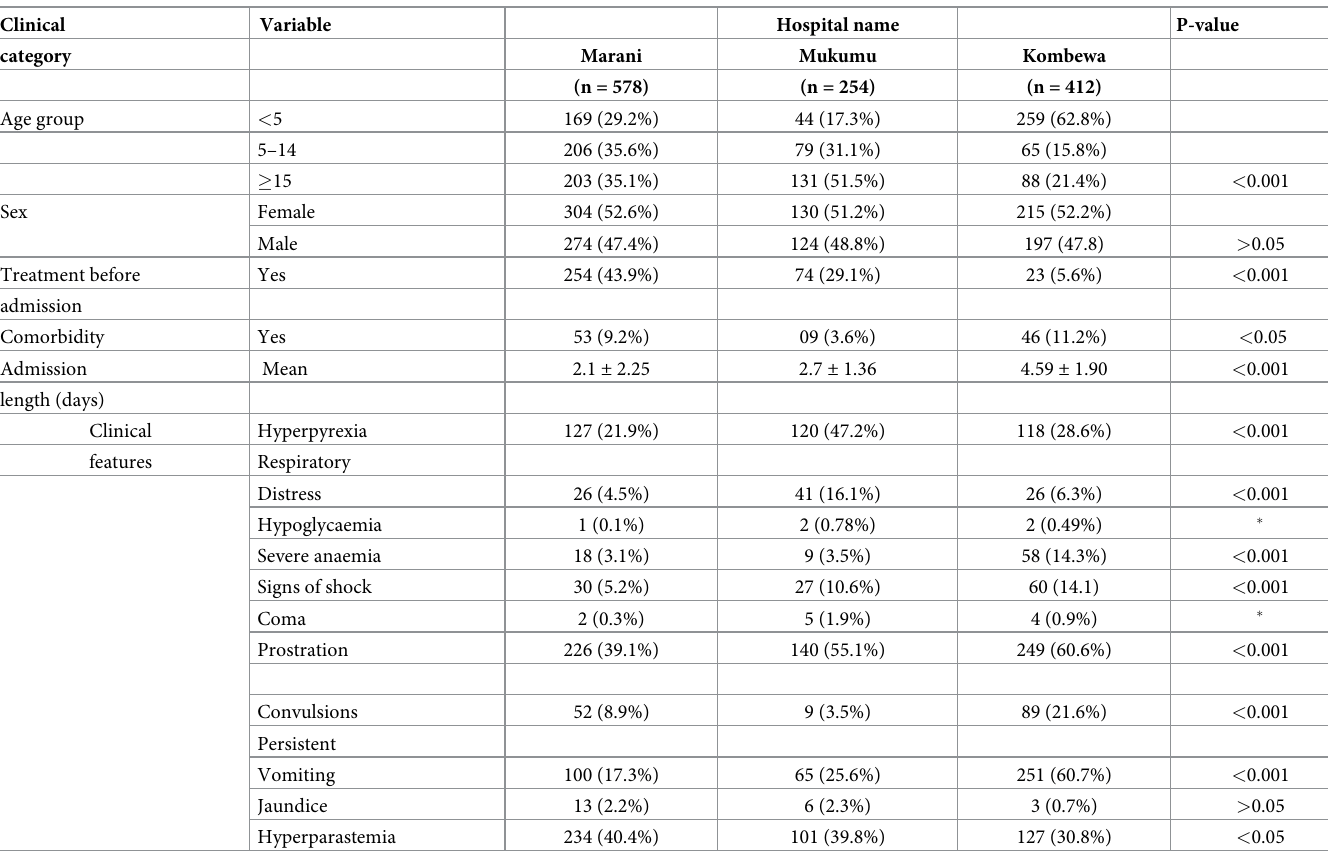
Table 3. Clinical presentations of severe malaria among patients admitted in three hospitals in Western Kenya from August 2015 to October 2016.